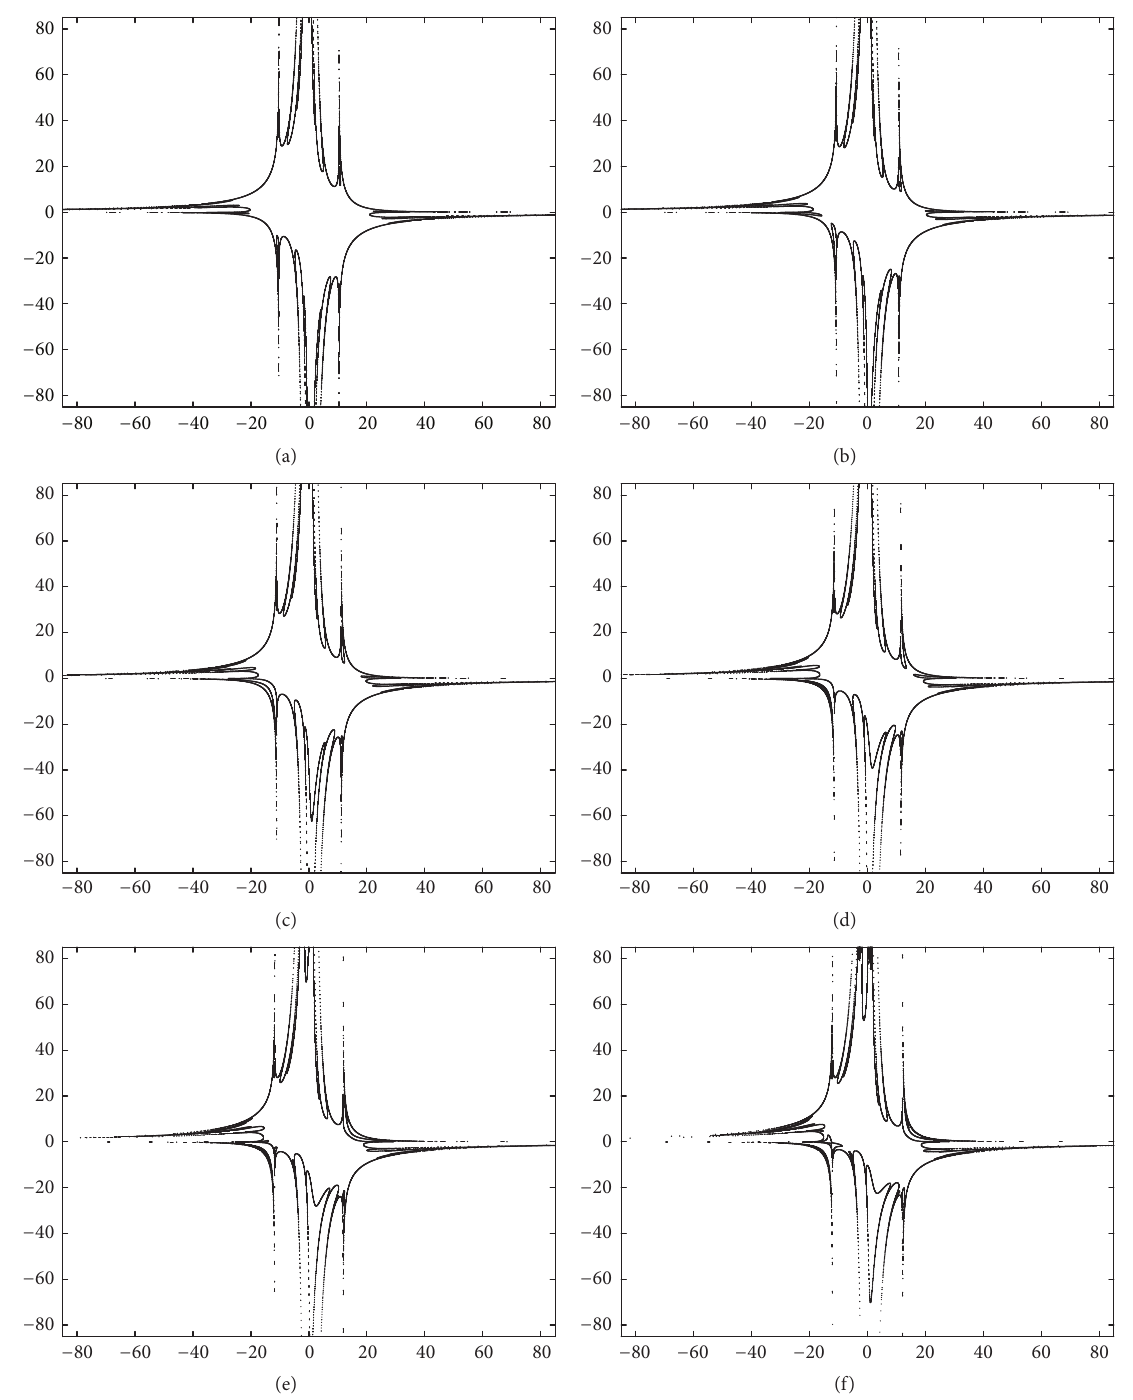
Figure 2: The change of the Julia sets of the controlled system when 𝑎 = 0.07, 𝑏 = 0.02 , and 𝛾 = 0.01 . (a) 𝑘 = 0.06 ; (b) 𝑘 = 0.14 ; (c) 𝑘 = 0.22 ; (d) 𝑘 = 0.30 ; (e) 𝑘 = 0.38 ; (f) 𝑘 = 0.45 .